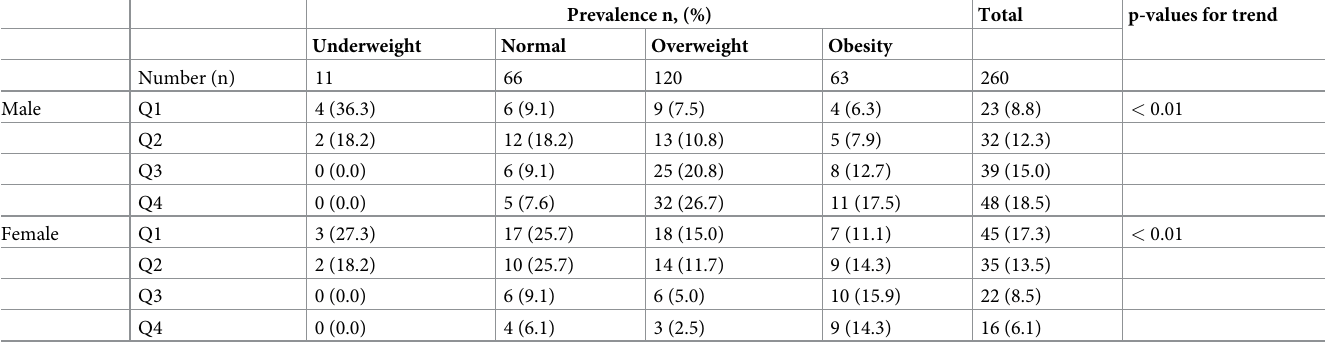
Table 4. Prevalence of underweight, normal, overweight and obesity between the SUA